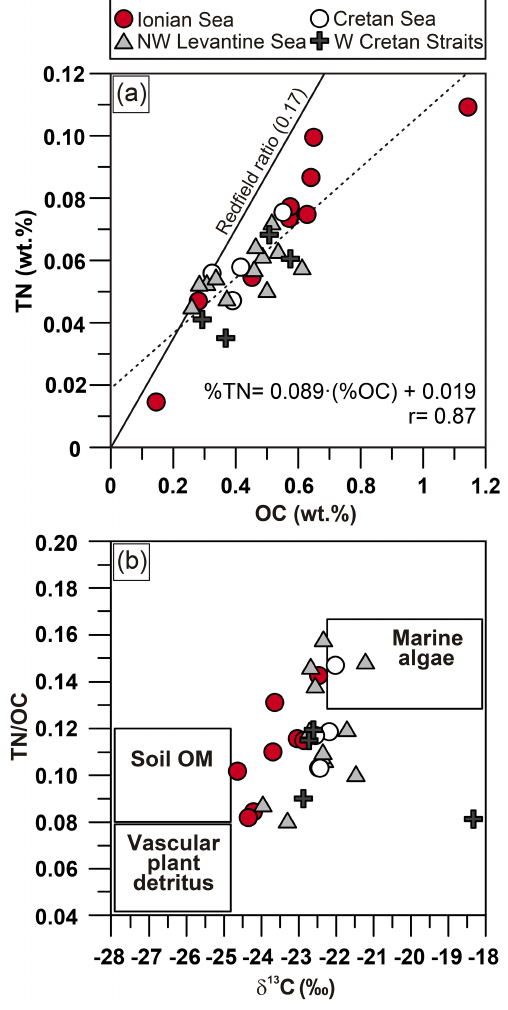
Figure 6. (a) Co-plot of the weight percent content of nitrogen (TN) vs. organic carbon (OC) for the deep-sea surface sediments anal- ysed. The linear fit of the data is shown (dotted line) along with the Redfield ratio N 16 / C 106 associated with the fresh marine phyto- plankton (0.17wt/wt). (b) Plot of molar TN / OC ratios vs. δ 13 C, in surface sediments of the deep eastern Mediterranean Sea. The compositional ranges of organic matter sources illustrated in plots (boxes) derive from previously published studies (see Sect.